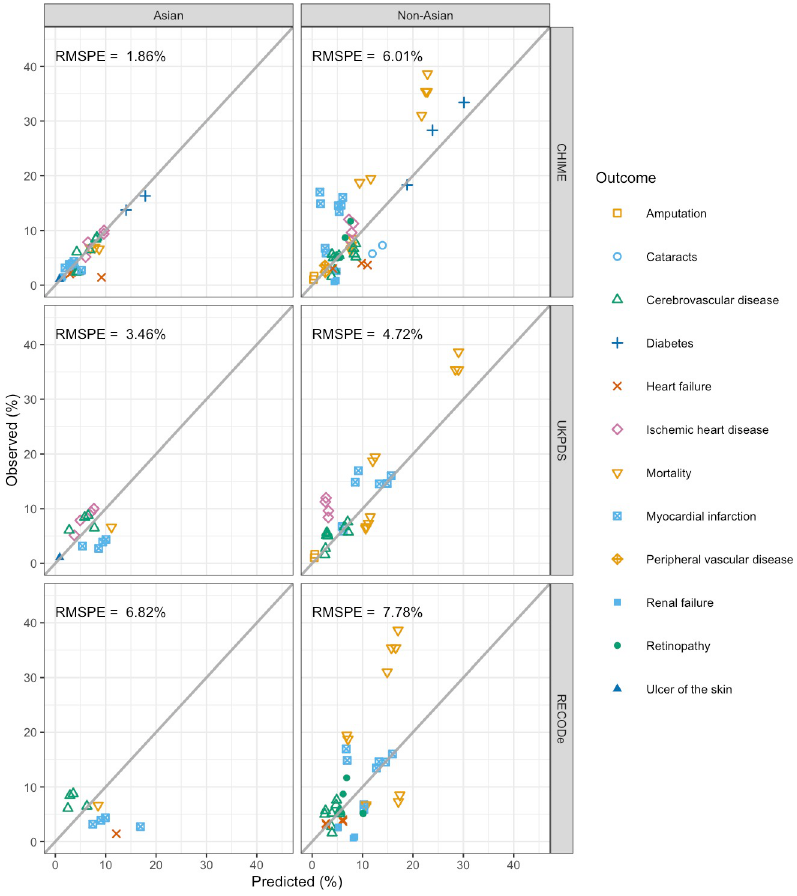
Fig 4. External validation of CHIME, UKPDS-OM2, and RECODe against trial data. Predicted percentage of events from CHIME, UKPDS-OM2, and RECODe against observed percentage in Asian trials (ACE, JPAD, J-EDIT, and JDCS) and non-Asian trials (ACCORD, ADVANCE, DPP, UKPDS 33, and UKPDS 80). See Table 3 for further details of trials. ACCORD AU : TheabbreviationlistinFig 4 hasbeenupdated : Pleaseverifythatallentriesarecorrect : , Action to Control Cardiovascular Risk in Diabetes; ACE, Acarbose Cardiovascular Evaluation; ADVANCE, Action in Diabetes and Vascular disease: preterAx and diamicroN-MR Controlled Evaluation; CHIME, Chinese Hong Kong Integrated Modeling and Evaluation; DPP, Diabetes Prevention Program; JDCS, Japan Diabetes Complications Study; J-EDIT, Japan Elderly Diabetes Intervention Trial; JPAD, Japanese Primary Prevention of Atherosclerosis with Aspirin for Diabetes; RECODe, Risk Equations for Complications Of type 2 Diabetes; RMSPE, root mean square percentage error; UKPDS-OM2, UK Prospective Diabetes Study Outcomes Model 2; UKPDS 33, UK Prospective Diabetes Study 33; UKPDS 80, UK Prospective Diabetes Study 80.